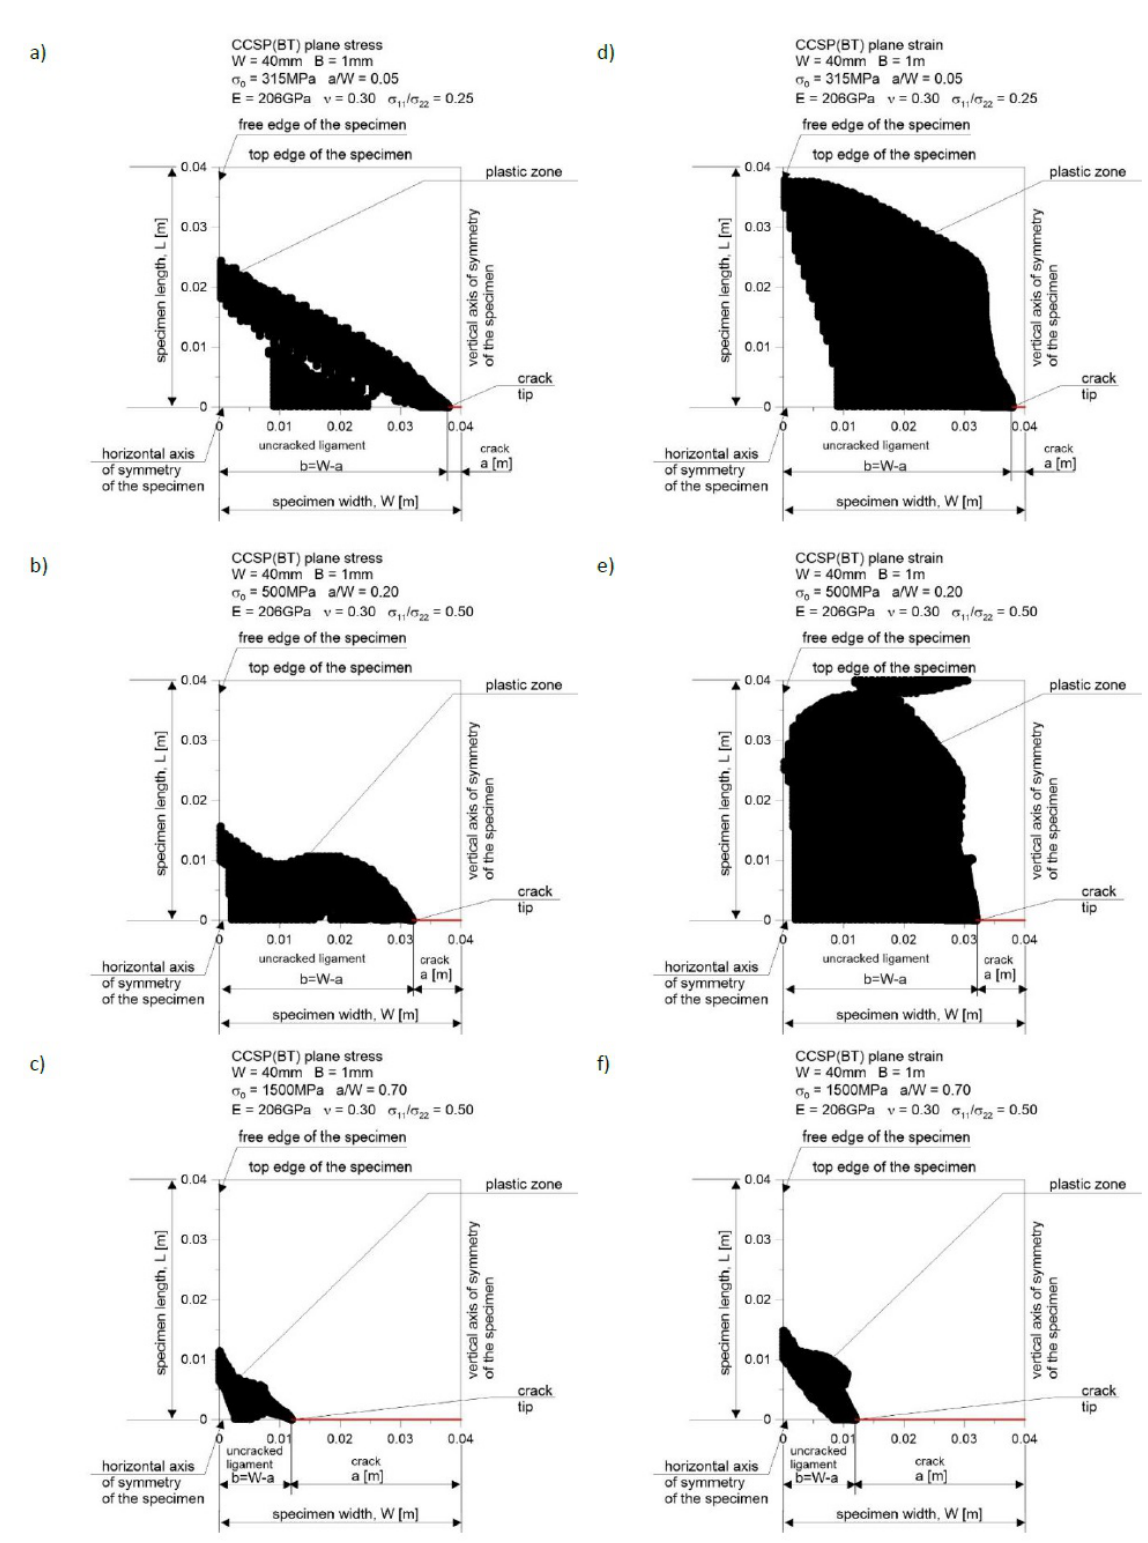
Figure 13: Shape of the plastic regions in the CCSP(BT) with: (a, d) a / W = 0.05, σ 0 = 315 MPa, σ 11 / σ 22 = 0.25; (b, e) a / W = 0.20, σ 0 = 500 MPa, σ 11 / σ 22 = 0.50; (c, f) a / W = 0.70, σ 0 = 1500 MPa, σ 11 / σ 22 = 0.50 – ((a-c) – plane stress, (d-f) – plane strain